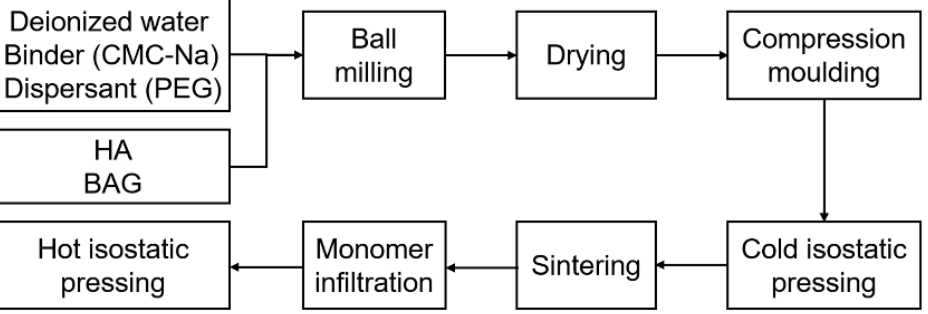
Figure 1. The processing steps for the preparation of the hybrid polymer–ceramic materials. Cured hybrid polymer–ceramic blocks were cut to the appropriate dimensions by a cutting machine (SYJ-400, Shenyang Kejing Auto-instrument Co., Ltd., Shenyang, China) equipped with an electroplated diamond saw blade. The spindle rotation speed of the cutting machine was 1500 rpm, and the feed rate was 2 mm/min. The test specimens were polished with 500, 2000, and 4000 grit silicon carbide (SiC) abrasive papers in turn. Finally, the dimensions of the cubic specimens were (25 ± 2) mm × (6 ± 0.1) mm × (3 ± 0.1) mm ( n =